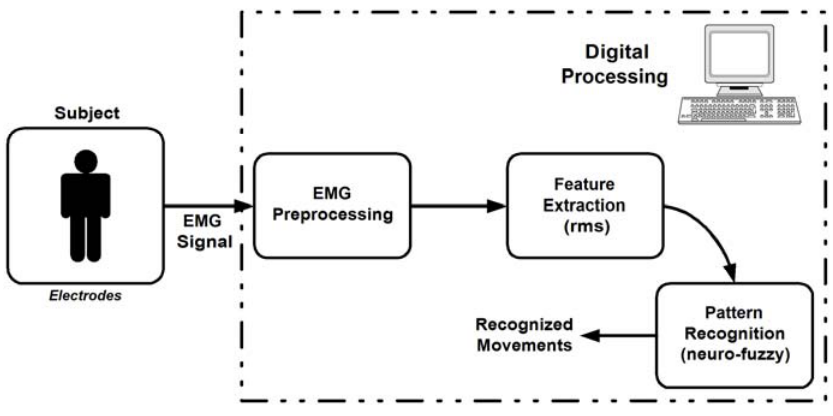
Figure 1. A block-diagram representation of the